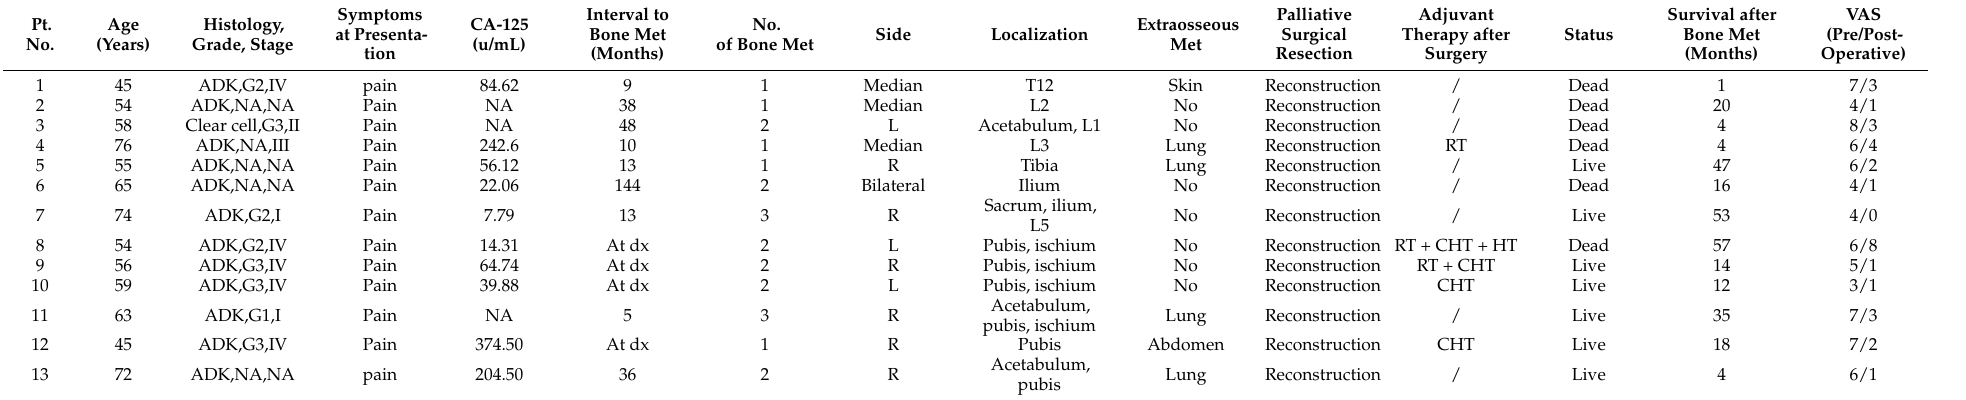
Table 1. Characteristics of 13 patients with primary bone metastases of EC treated by surgery at Peking University People’s